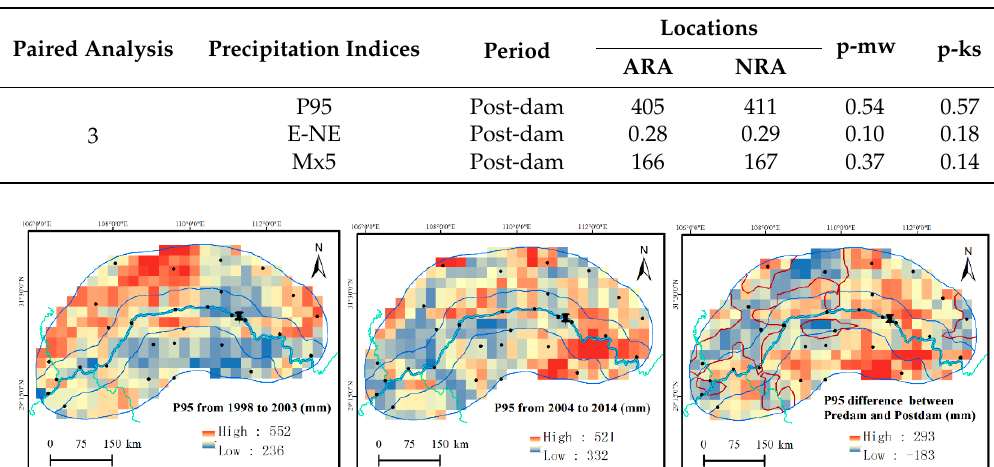
Table 9. Statistical difference tests for the mean and distribution in the extreme rainfall indices